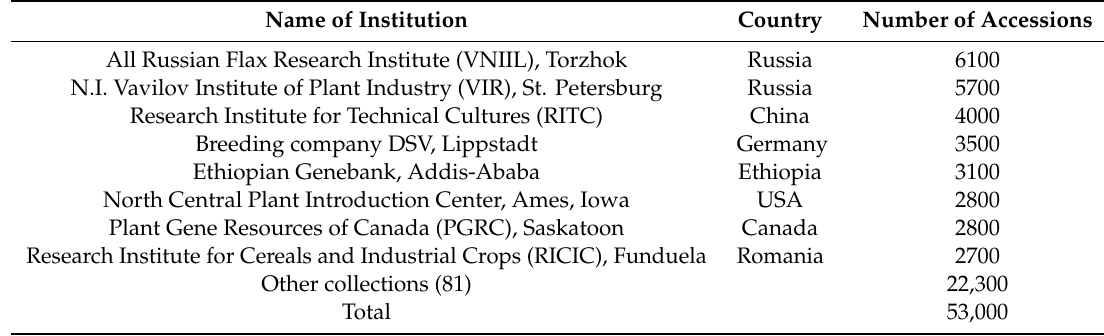
Table 4. List of flax accessions held at germplasm repositories worldwide, sorted by total number of accessions (table adapted from Diederichsen and Richards, (2003))